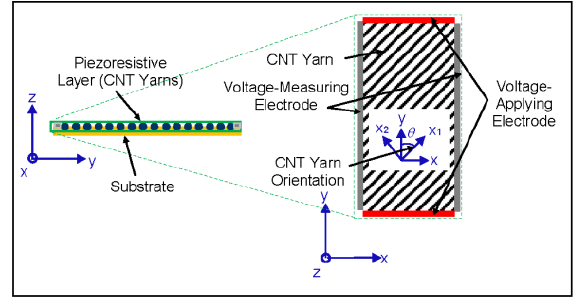
Figure 1. Schematic of cross-section of the foil strain gauge sensor comprising CNT yarns. Inset: top schematic view of the arrangement of the CNT yarns in a unidirectional configuration [65].